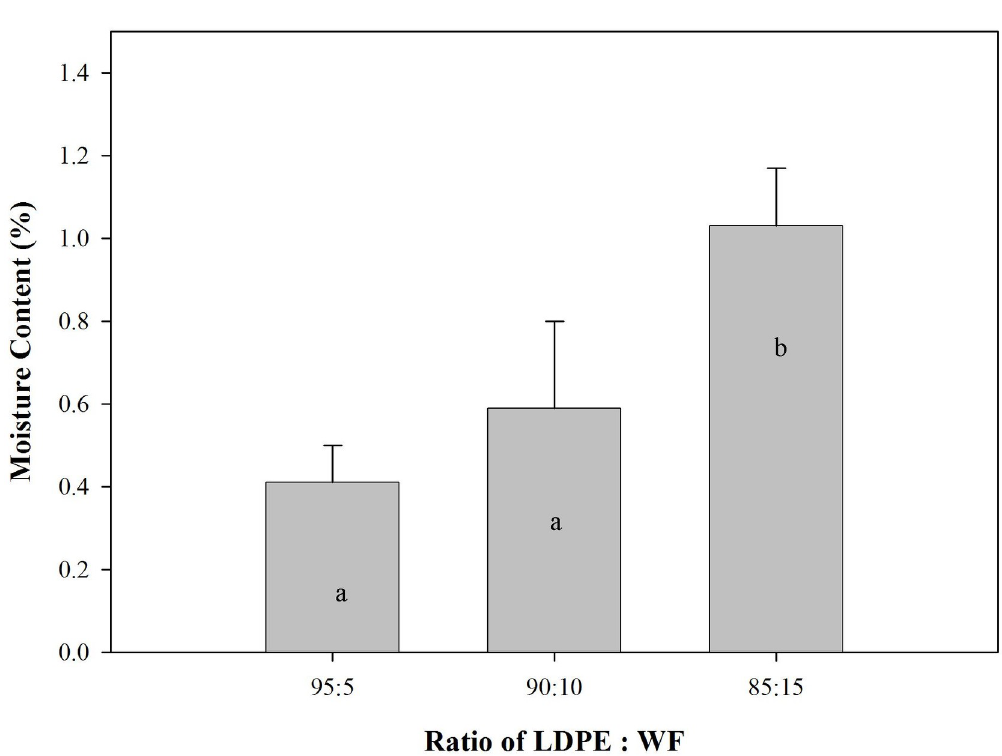
Fig 3. Moisture content of predominantly plastic WPCs (Different letter at the bar are statistically different according to the DMRT at α = 0.05).